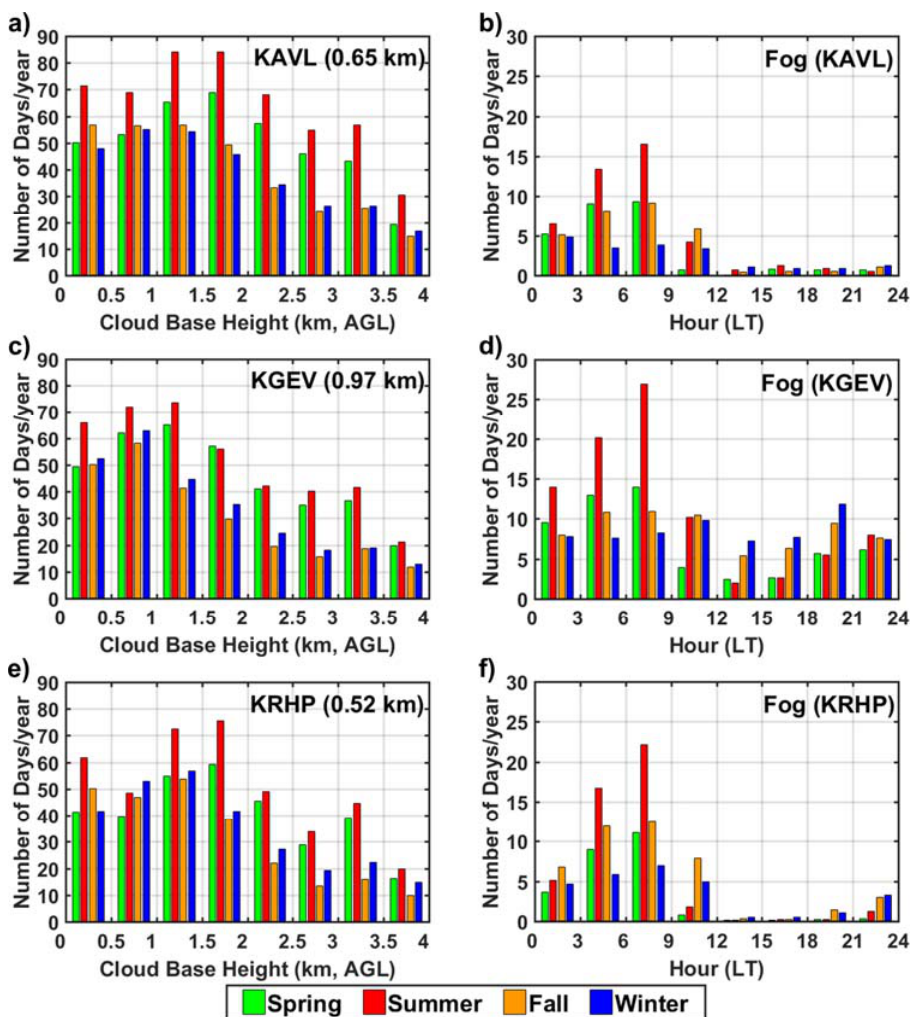
Figure 4. ( Left ) Seasonal histograms of ceilometer cloud base heights (CBHs) at KAVL ( a ), KGEV ( c ), and KRHP ( e ) during June 2006–October 2016. Note the elevation of each site is denoted in parentheses after its name; ( Right ) Seasonal and diurnal cycles of fog occurrences (visibility < 5/8 Statute Miles) at the corresponding ceilometer sites (KAVL: b ; KGEV: d ; KRHP: f ) during the same period. Note the spring season represents April-May-June, the summer season represents July-August-September, the fall season represents October-November-December, and the winter represents January-February-March.